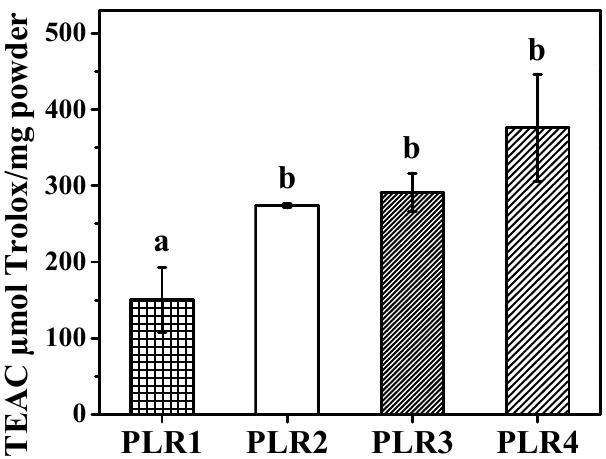
Figure 5. Antioxidant profile of spray-dried lipid carriers expressed as Trolox equivalents per mg of powder. Same letter means significantly different in Tukey’s multiple comparison test ( p < 0.05).